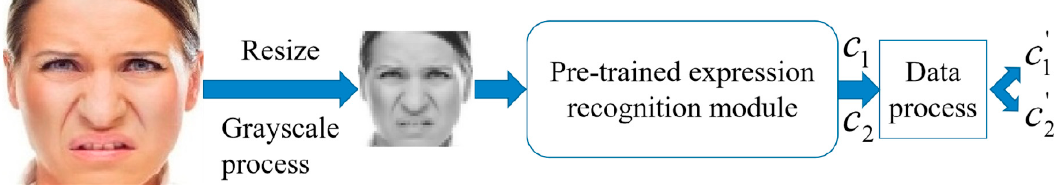
Figure 6. Facial image is transformed into 48×48 gray images to feed the pre-trained recognition module. Then the probabilities of seven kinds of expressions including ‘anger,’ ‘disgust,’ ‘fear,’ ‘happiness,’ ‘neutral,’ ‘sadness,’ and ‘surprise’ are calculated. The first two probabilities ( c 1 ,c 2 ) are selected and finally adjusted into standard data c(c 1’ ,c 2’ ) as combined style labels to guide the process of font generation.